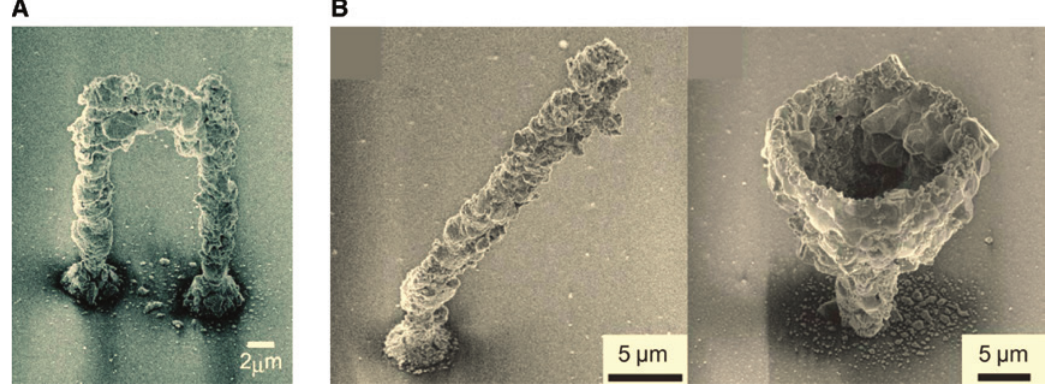
Figure 4: Influence of the